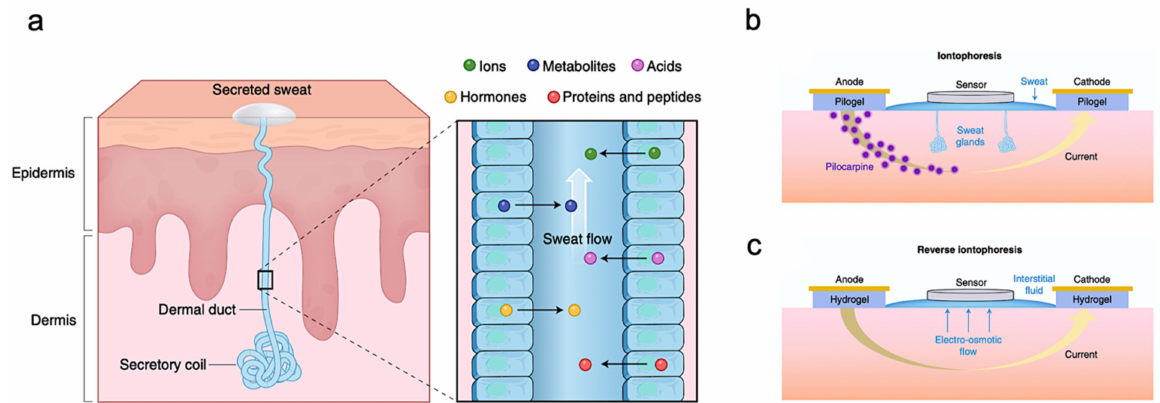
Figure 2. Sweat gland structure and biomarker partitioning. ( a ) Illustration of the sweat production process and metabolites that passed along with sweat. ( b ) Depiction of Iontophoresis to stimulate local sweat secretion at a selected site. ( c ) Reverse iontophoresis drives interstitial fluid through the epidermis to the skin surface. Reproduced with permission from ref. [69], Copyright from 2018, Nature Publishing